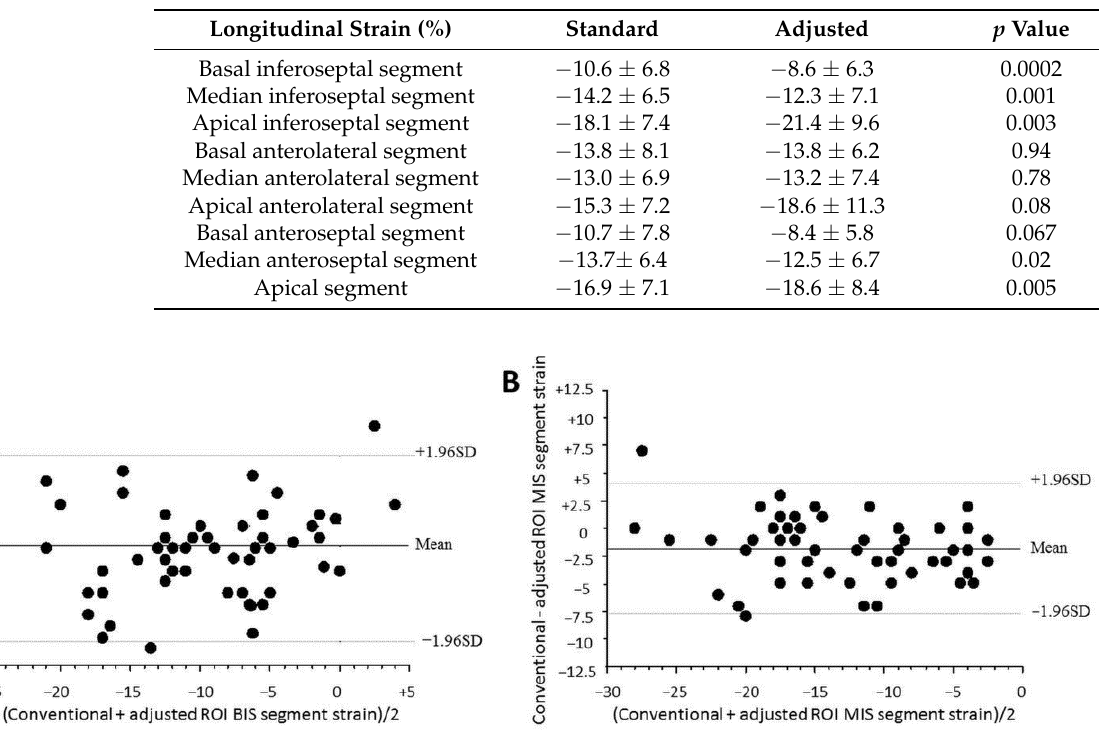
Figure 2. Bland–Altman plots of ( A ) basal inferoseptal (BIS) segment strain and ( B ) median inferoseptal segment strain for conventional and mid-wall adjusted ROI strains. Dashed lines, 1.96 SDs from the mean. BIS: basal inferoseptal, MIS: median inferoseptal, ROI: region of interest.